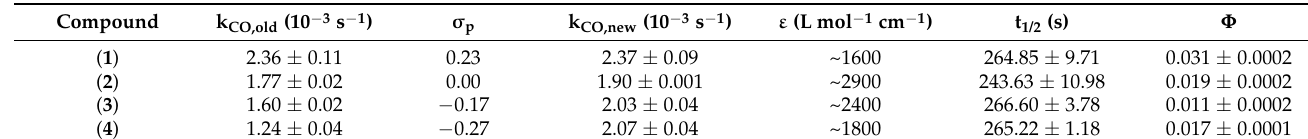
Table 4. Summarized CO release constant rates (k CO ), Hammett sigma constants ( σ p ), MLCT absorp- tion coefficient ( ε ), half-life times (t 1/2 ), and quantum yield ( Φ ) for compounds ( 1 )–( 4 ).